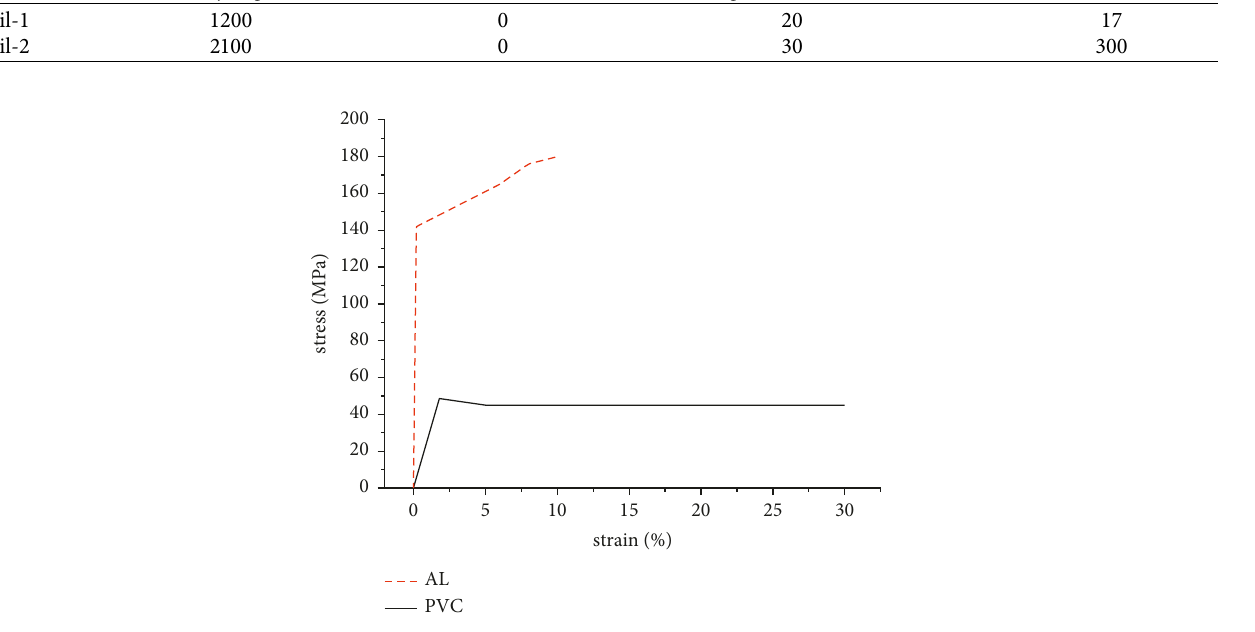
Figure 3: Stress-strain curve of AL and PVC